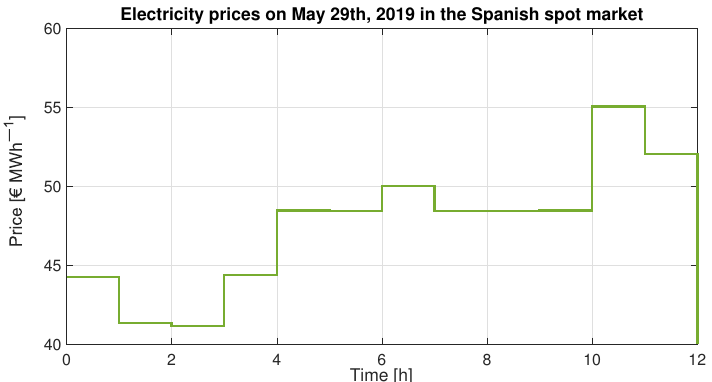
Figure 9. Electricity prices corresponding to 29 May 2019 in the Spanish spot market, once scaled into a 12 h timeframe [31].